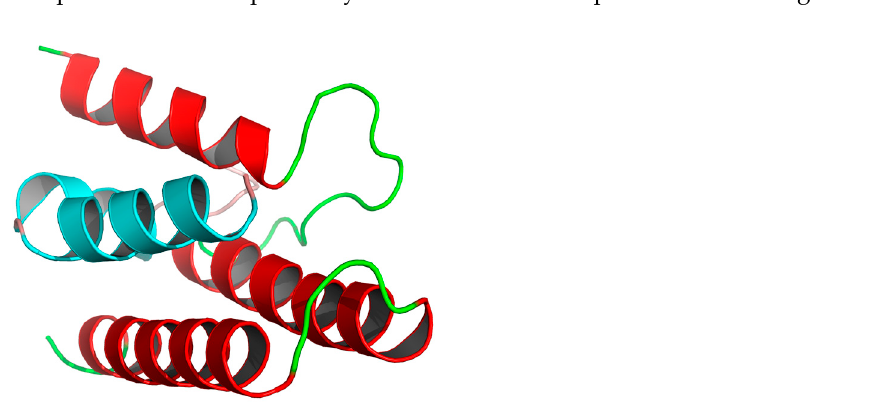
Figure 1. An overall ribbon diagram showing the structure of the complex, with helices from PB1 colored red, and helices from PB2 colored cyan. Coil regions are colored green.